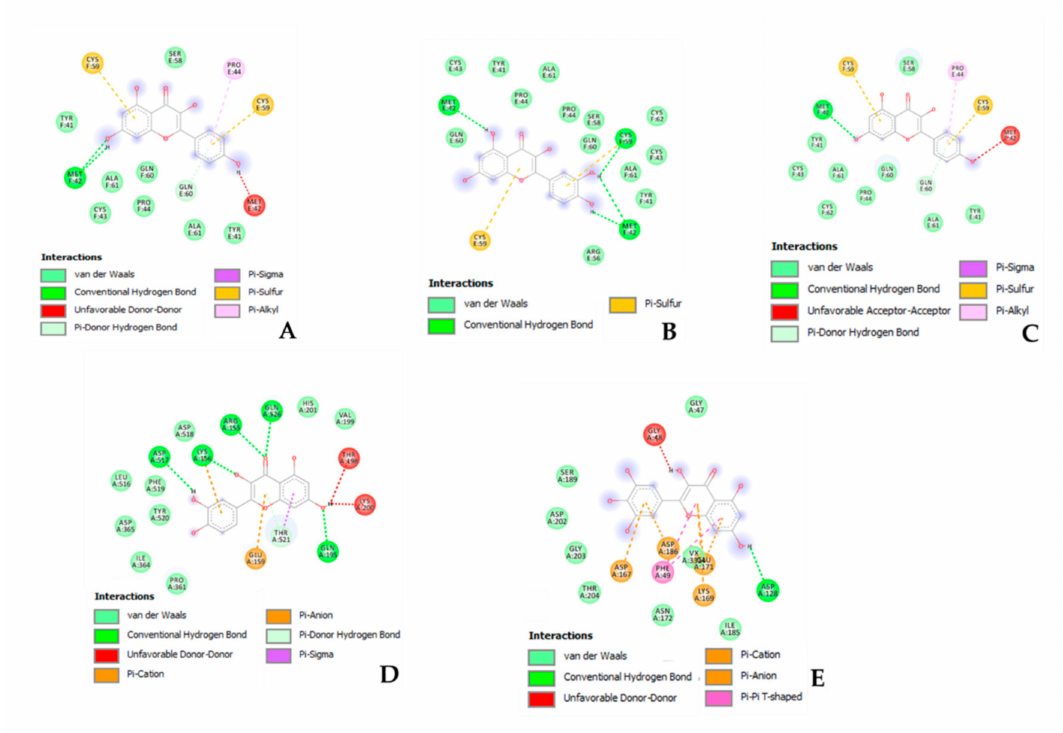
Figure 2. Putative interaction between kaempferol and estrogen receptor 1 (ESR1; PDB: 1HCQ); Free energy of binding ( ∆ G) and affinity (Ki) are − 7.2 kcal/M and 5.4 µ M, respectively ( A ). Putative interaction between apigenin and estrogen receptor 1 (ESR1; PDB: 1HCQ); Free energy of binding ( ∆ G) and affinity (Ki) are − 7.3 kcal/M and 4.5 µ M, respectively ( B ). Putative interaction between quercetin and estrogen receptor 1 (ESR1; PDB: 1HCQ); Free energy of binding ( ∆ G) and affinity (Ki) are − 7.5 kcal/M and 3.2 µ M, respectively ( C ). Putative interaction between quercetin and hemopoietic cell kinase (HCK; PDB: 1QCF); Free energy of binding ( ∆ G) and affinity (Ki) are − 8.2 kcal/M and 1.0 µ M, respectively ( D ). Putative interaction between myricetin and pim-1 oncogene (PIM-1; PDB: 3BGZ); Free energy of binding ( ∆ G) and affinity (Ki) are − 7.3 kcal/M and 4.5 µ M, respectively ( E ).